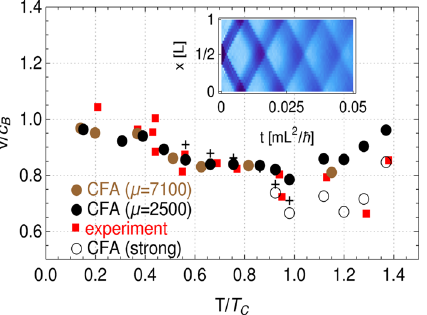
Figure 1. Speed of sound normalized to the Bogoliubov sound speed (at zero temperature) shown as a function of T / T c . Black and brown bullets (obtained at different values of chemical potential, in units of (cid:31) 2 / mL 2 , as indicated in the legend) come from numerical simulations whereas red squares are experimental results 9 . 0.25 and d (cid:31) 5 / 16 . Open circles Numerical results are obtained within weak perturbation scheme, with w / L ≈ represent numerical data for stronger disturbance, w / L (cid:31) 0.25 and d > 5 / 16 . Crosses are the outcome of two- fluid model 1,15 , showing the speed of second sound. Inset: Propagation of sound waves in a box potential. At each time two-dimensional density is integrated along the direction perpendicular to the sound propagation and then averaged over a hundred realizations. The effective one-dimensional density is shown as a function of 0.25 in units of the box length L , and the depth of a density time. The width of the density depletion equals w = 0.37 T 42275 ). The temperature is T 0.05mL 2 / (cid:31) dip is 5/16 of initial density ( N c . Total evolution time t = = = 38 µ m . The spatial resolution here is 0.76 µ m which is 1.58 of the healing length corresponds to 100 ms for L = (cid:31) / √ mng . All figures were created with the help of Wolfram Mathematica (version 12.1, https:// www. wolfr ξ = am. com/ mathe